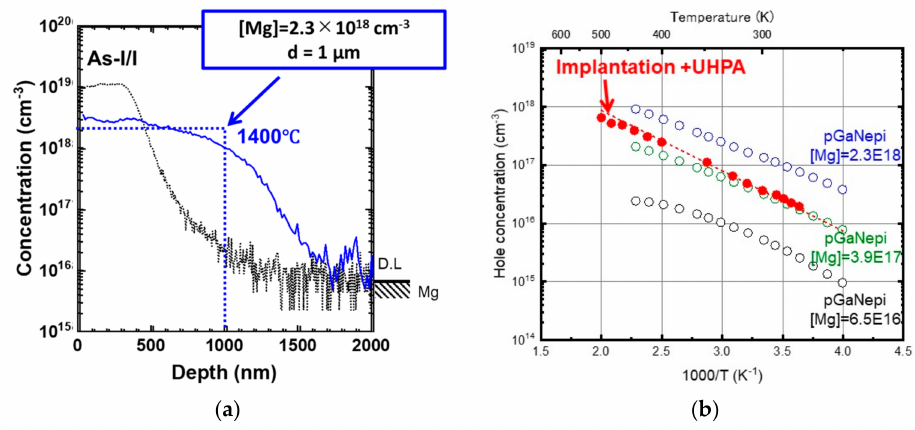
Figure 5. ( a ) Comparison of Mg profile after implantation and UHPA; ( b ) temperature-dependent hole concentration for samples processed by Mg ion implantation and UHPA compared to MOVPE-GaN doped with Mg; modified from Sakurai et al. [24] with permission of AIP